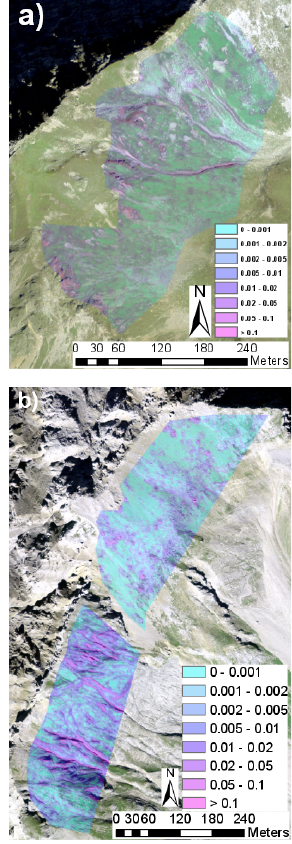
Fig. 5: Evolution of snow depth from 1 November until Fig. 6. Terrain roughness derived from a DTM with 1m resolu- 31 March measured (a–c) at the weather station WAN7 in Fig. 6: Terrain roughness derived from a DTM with 1m res- Steint¨alli and (d–f) at the weather station Donin du Jour in tion, for a 5m scale in (a) the ST basin and (b) the VdlS basin. olution, for a 5m scale in (a) the ST basin and (b) the VdlS the Vall´ee de la Sionne. The vertical blue lines correspond to Swissimage © 2013 swisstopo (5704 000 basin. Swissimage© 2013 swisstopo (5704 000 000). the acquisition times of the laser scans.